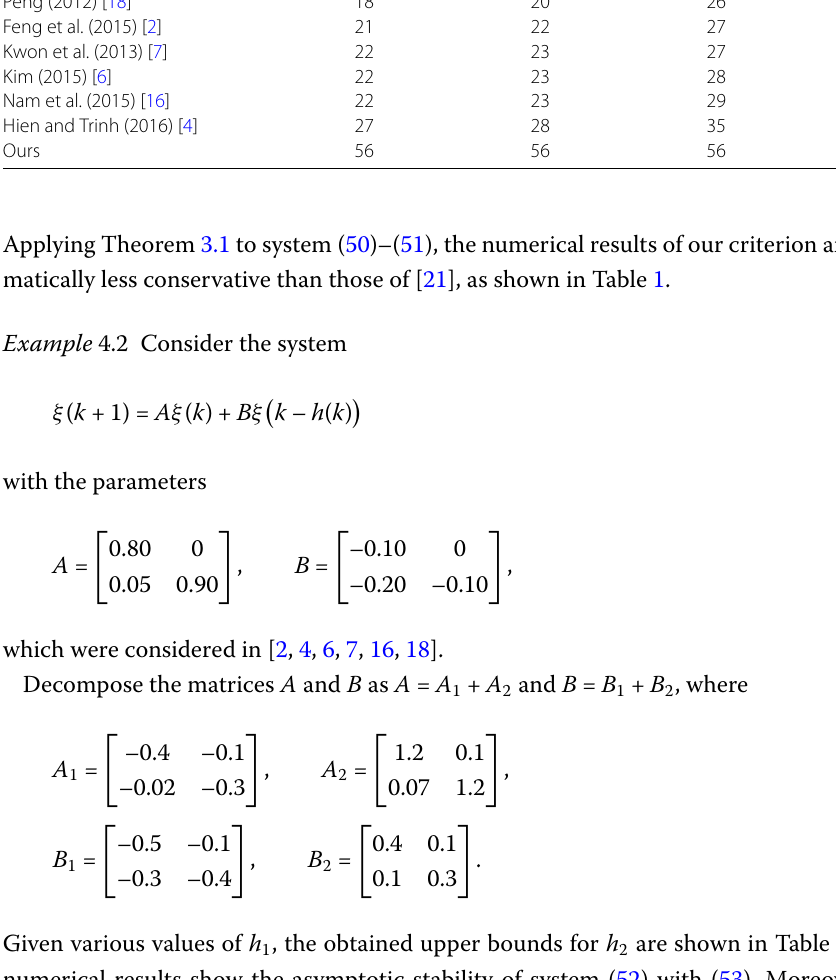
Table 2 The maximum upper bounds of h 2 for Example 4.2 h